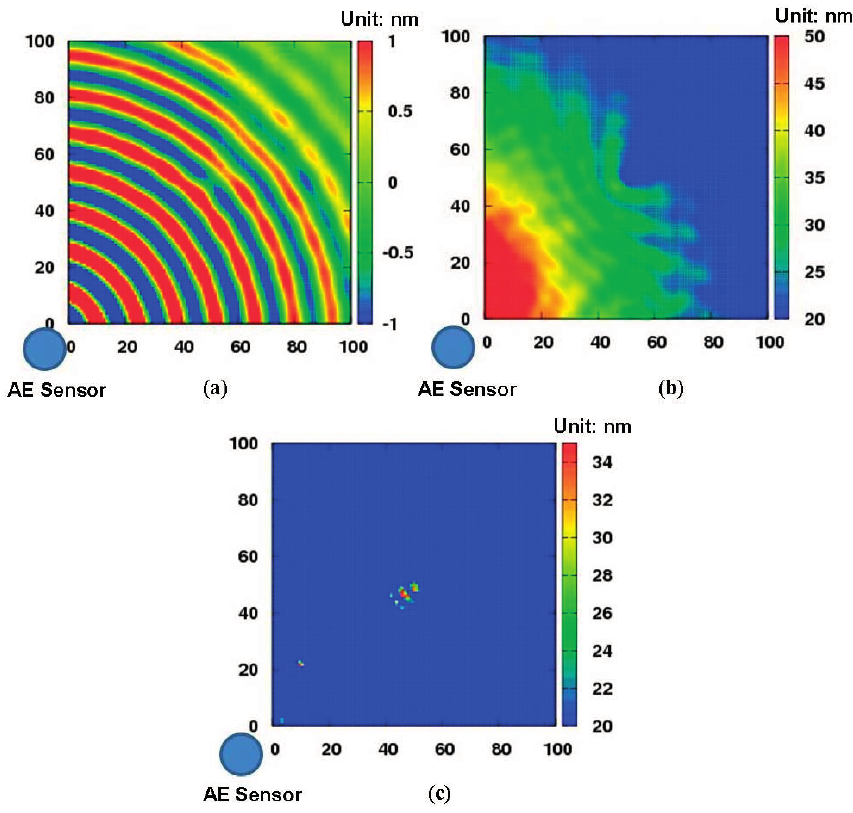
Figure 9. Diagnostic images of a circular dent: ( a ) snapshot at 100 µs; ( b ) distribution image of kinetic energy; ( c ) the improved diagnostic